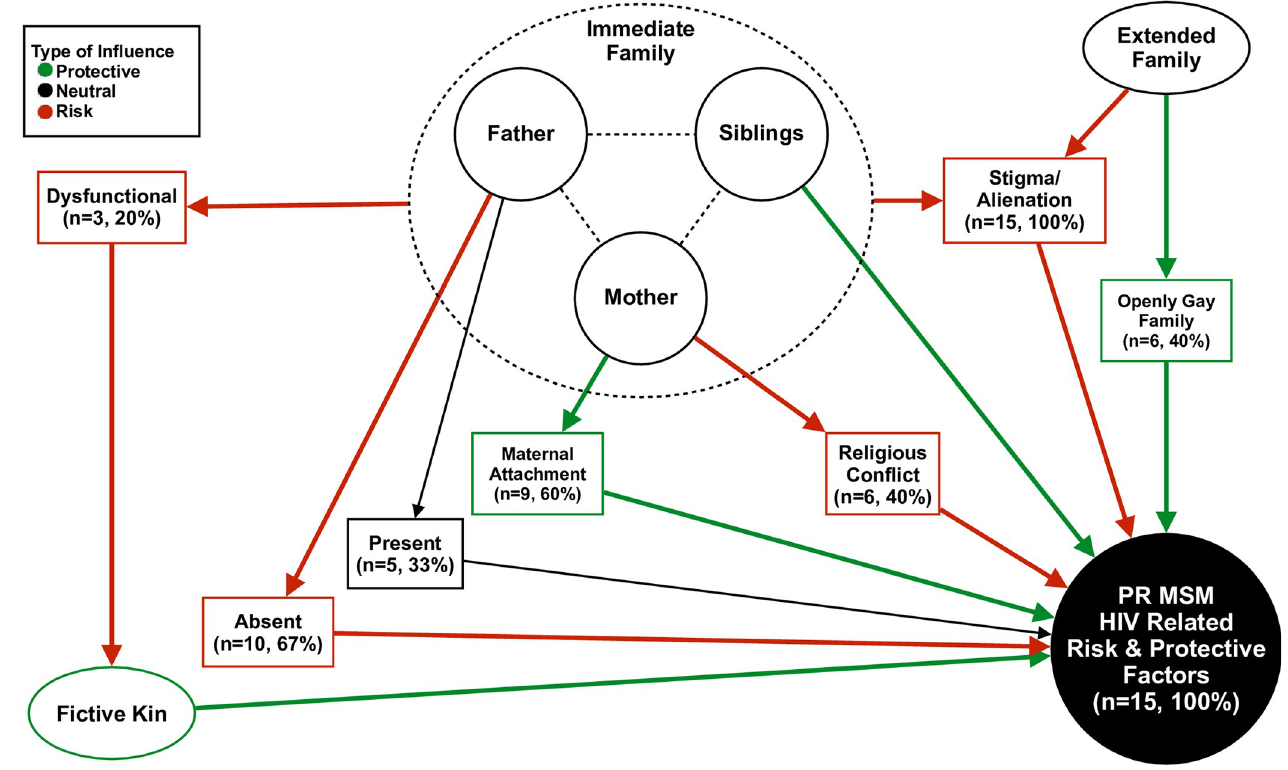
Fig 1. Thematic framework for conceptualizing family-based HIV related risk & protective factors for PR MSM (N = 15) in San Juan, PR.